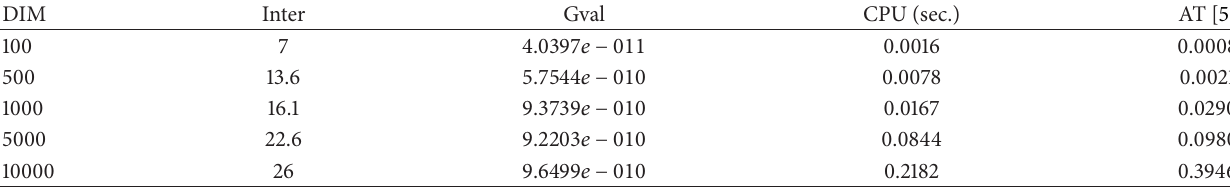
Table 1: Problem (1) with a , b , 𝑐 randomly generated in different intervals.